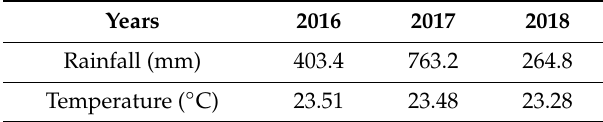
Table 1. Total rainfall and mean temperature data of the cropping